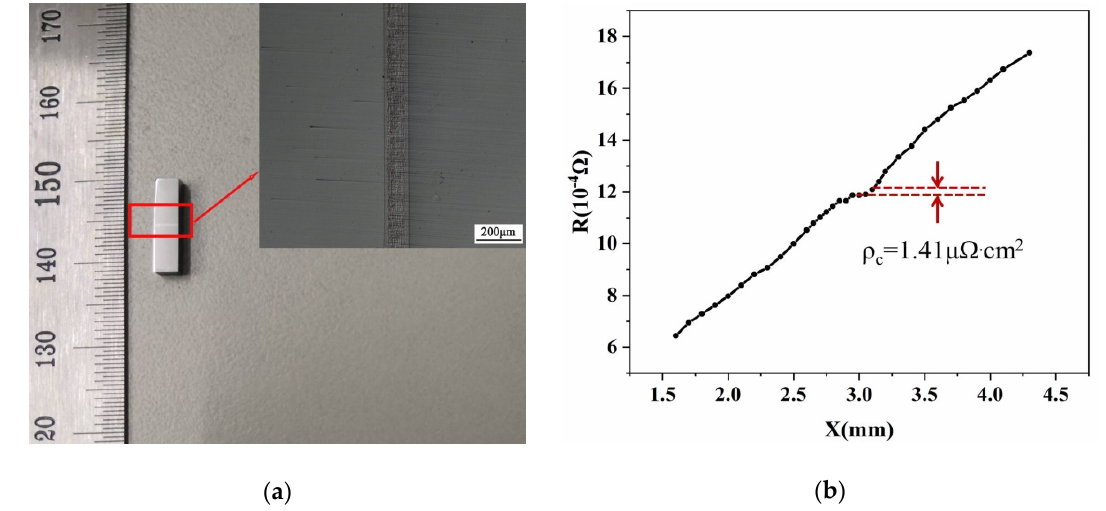
Figure 7. ( a ) The skutterudite–electrode–skutterudite sandwich structure fabricated by the diffusion bonding method. ( b ) The measured specific contact resistivity of the Co-Mo/skutterudite interface.